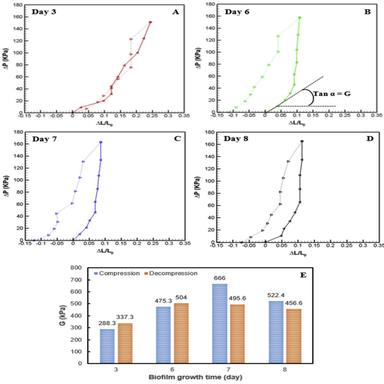
Normal Stress/strain curves obtained at different times of biofilm development during compression (solid line) and decompression (dotted line) (A, B, C, D) and variation of bulk modulus (G) of biofilm over time under compression/decompression processes (E).